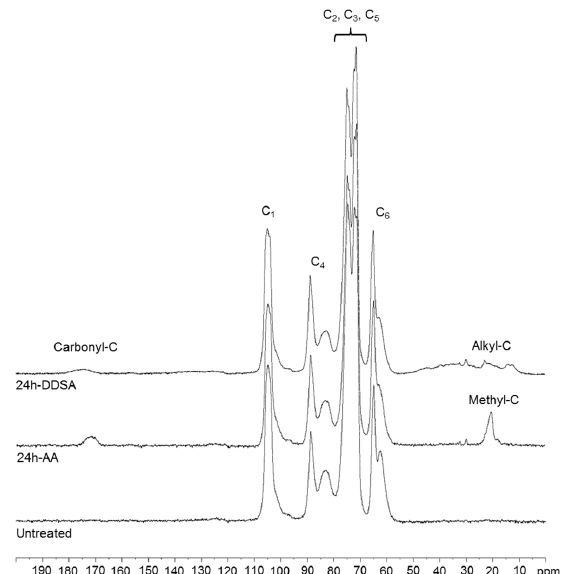
Figure 2. 13 C Cross-Polarization Magic Angle Spinning Nuclear Magnetic Resonance (CP-MAS NMR) spectra of unmodified NFC compared to NFC modified with DDSA and AA, respectively, for 24 h.